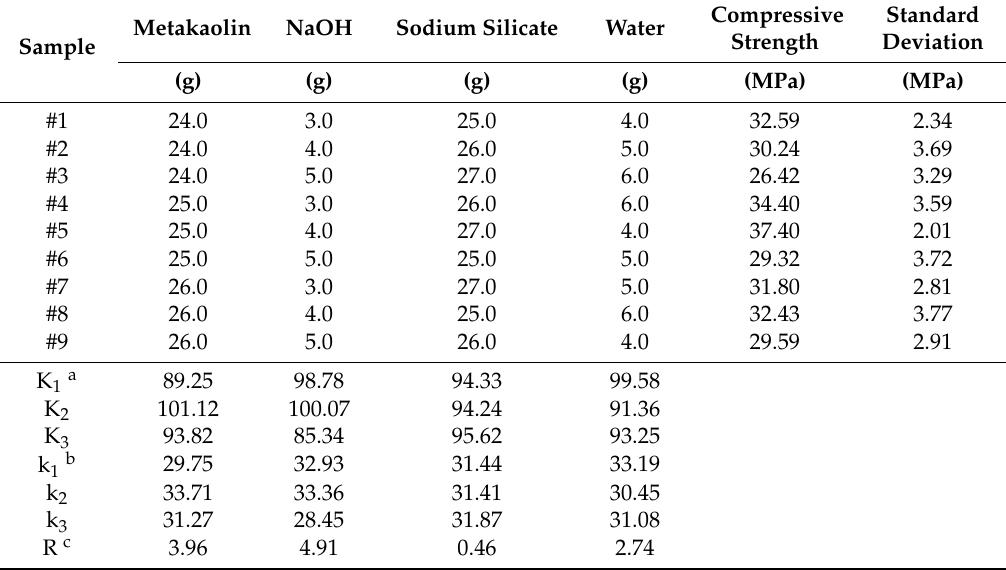
Table 4. Orthogonal experiment of alkali activated metakaolin-based geopolymer with different